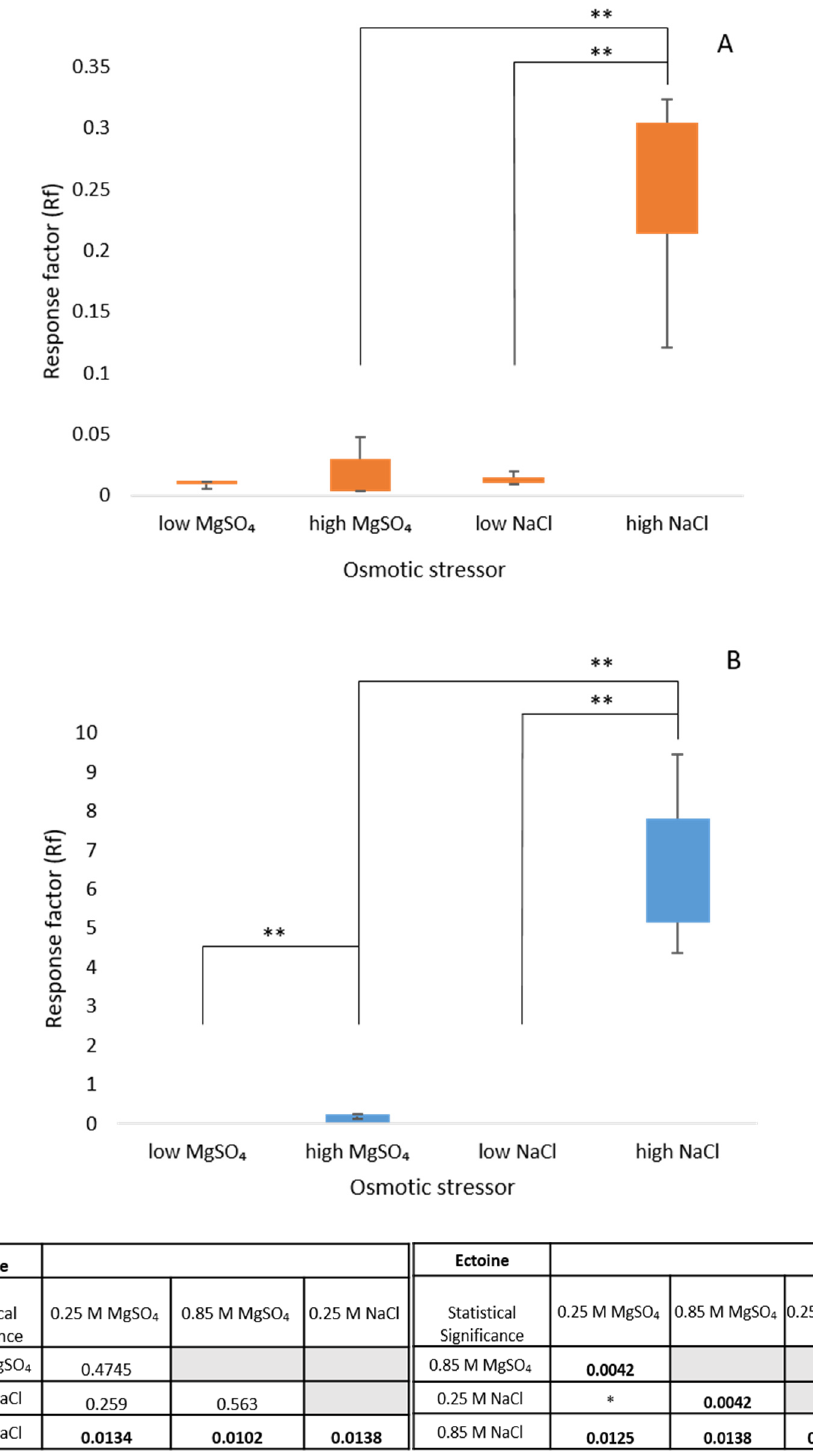
Figure 3. Standardized response of ( A ) betaine and ( B ) ectoine in Acidihalobacter aeolianus grown in the presence of either NaCl or MgSO 4 from three biological replicates. * Values were 0 for this comparison. ** Indicates statistically significant difference as given in ( C ).